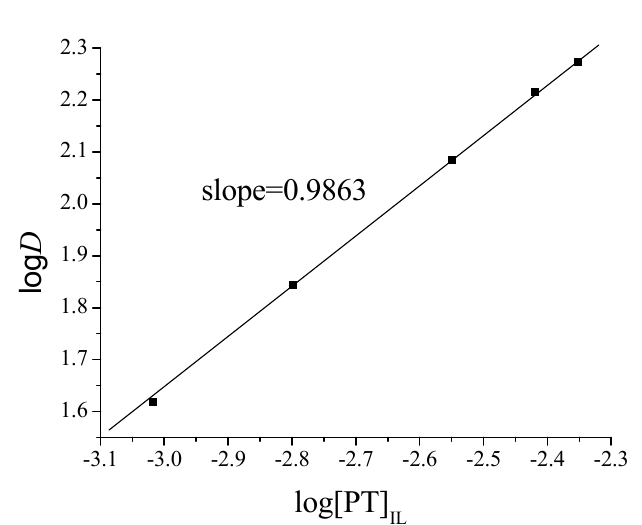
Figure 3. Plot of log D as a function of log[PT] in TC-SLE system. pH = 5.50, [Fe 2+ ] = 1.0 × 10 − 5 mol·L − 1 . The slope of lines indicated was obtained by the least squares fitting in the figure.